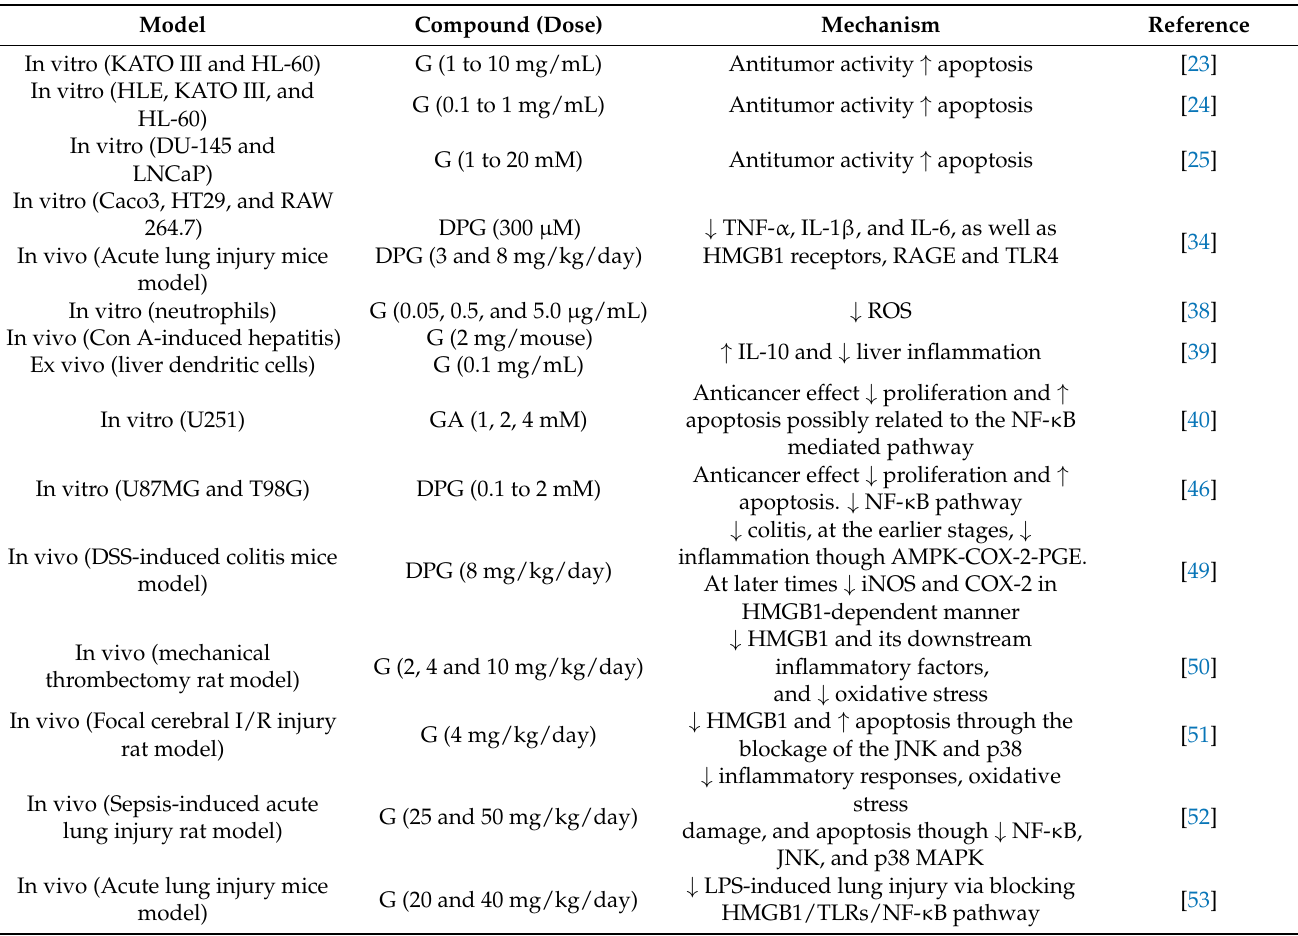
Table 1. Summary of studies showing the autoinflammatory and anti-tumoral effects of G, GA, and